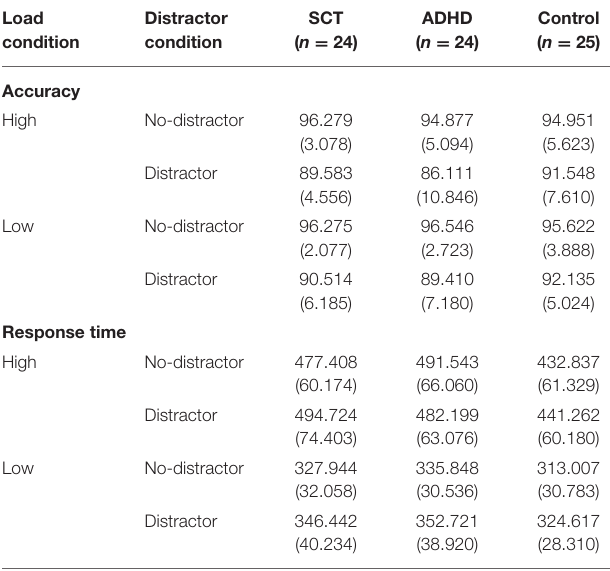
TABLE 2 | Mean (SD) of Accuracy and response time under each load and distractor condition for groups in irrelevant distractor task. Load